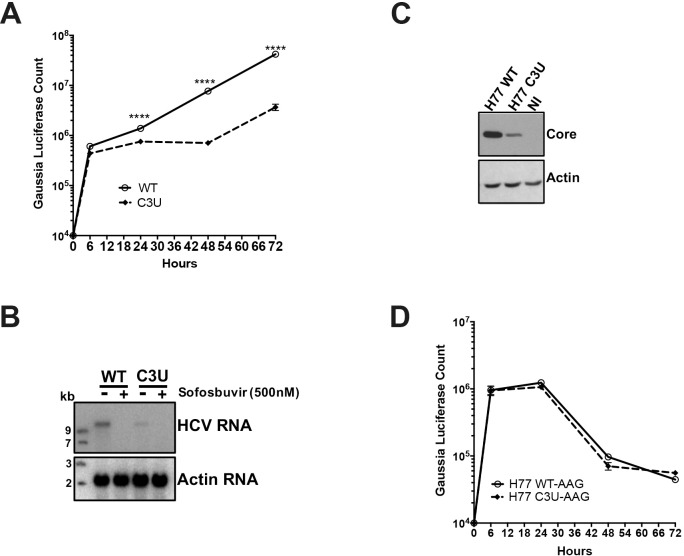
Effects of C3U mutation on HCV RNA replication and translation.(A) HCV RNA replication was monitored by the expression of GLuc secreted into the supernatants of wild-type and C3U RNA transfected Huh7.5 cells. Supernatants were collected at the indicated time points. (B) Wild-type and C3U H77.S3/GLuc RNA abundances three days post-transfection in untreated and cells treated with the NS5B inhibitor sofosbuvir (500nM). (C) Effects of C3U mutation on HCV core protein levels examined by Western blot analysis at three days post-H77.S3/GLuc RNA transfection. (D) Translation of the replication defective (AAG) wild-type and C3U H77.S3/GLuc RNAs at multiple several points post-transfection. The data are representative of 3 independent replicates (****p<0.0001,Student’s t-test).